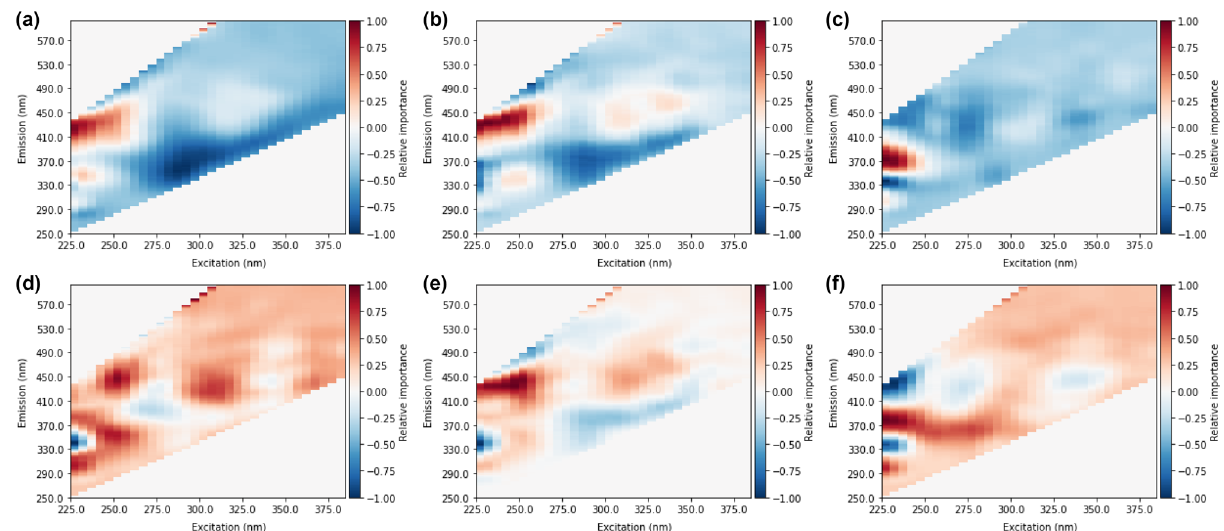
Figure 5. Heat maps from random occlusion of variable importance for MLP prediction of ( a ) total THMs, ( b ) trichloromethane, ( c ) bromodichloromethane, ( d ) total HAAs, ( e ) trichloroacetic acid, ( f ) dichloroacetic